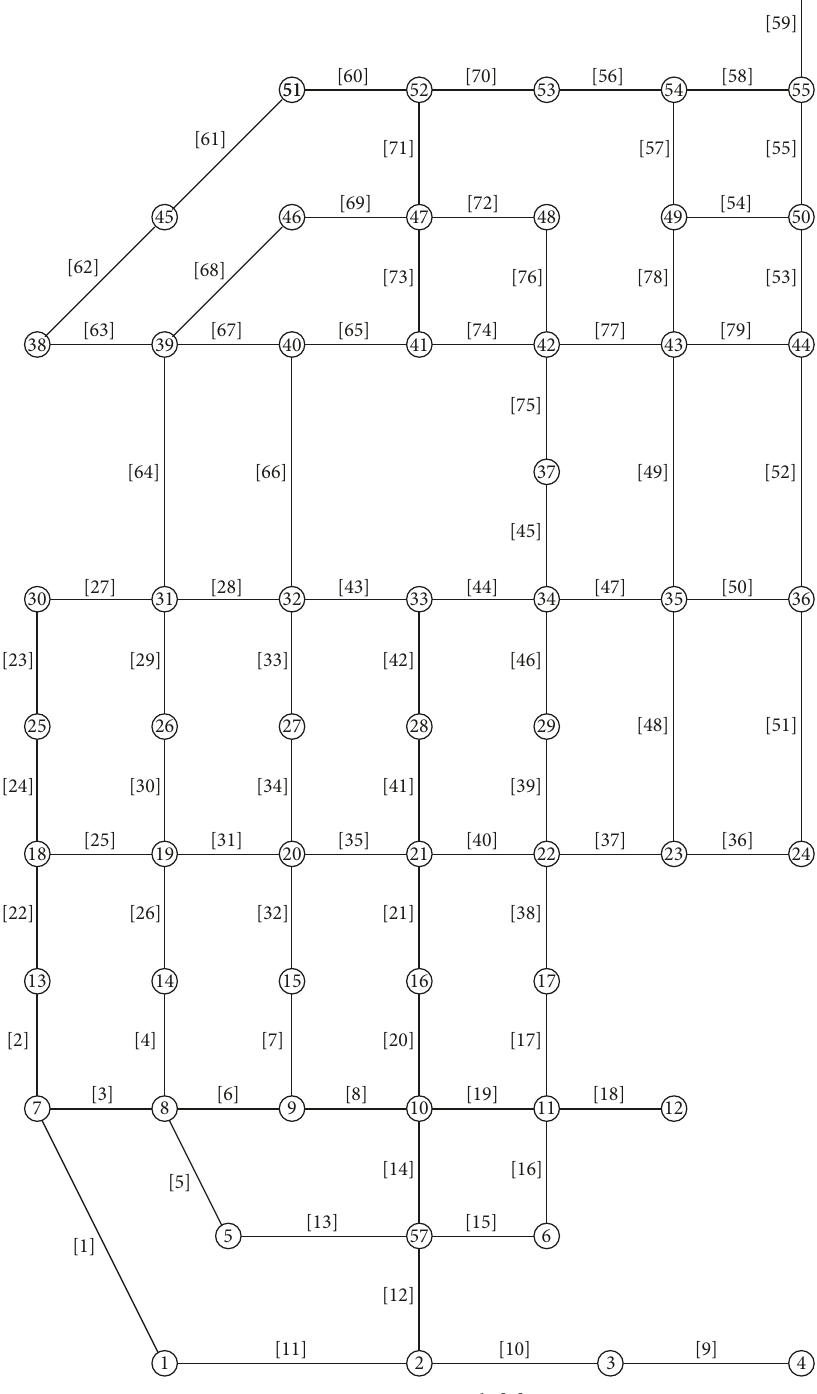
Figure 4: Base graph